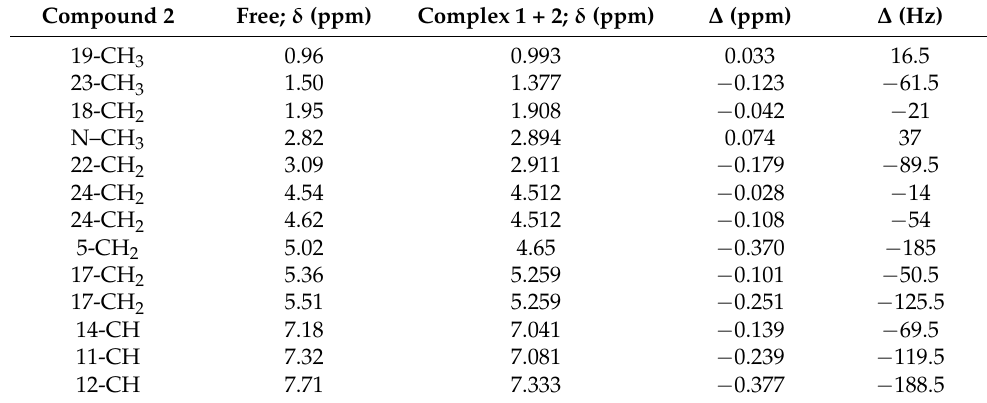
Table 2. The 1 H NMR chemical shift changes in SN38 derivative 2 after addition to DNA.